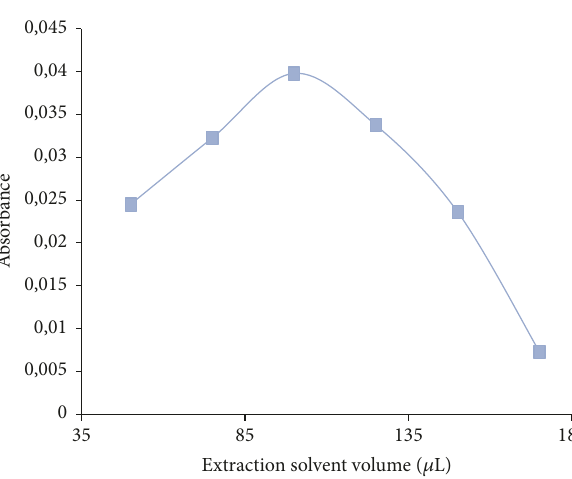
Figure 2: The effect of the extraction solvent volume on absorbance of lead with SFODME. Extraction circumstances: Pb: 10 𝜇 gL −1 ; pH: 9; extraction solvent, 1-undecanol (100 𝜇 L); sample volume, 10 mL;dispersivesolvent,acetonitrile(200 𝜇 L);%1.6NaCl;chelating reagent [PAN], 1 × 10 −4 molL −1 .